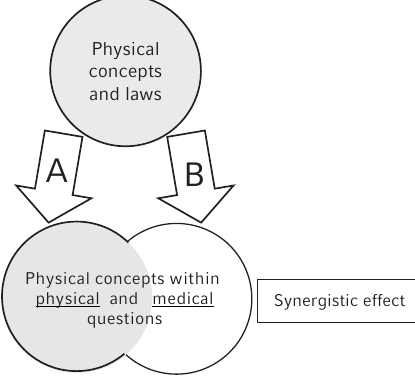
FIG. 2. Addressee-specific experiments (cid:1) gray (cid:2) within physical and medical domains. For details concerning the arrows A and B